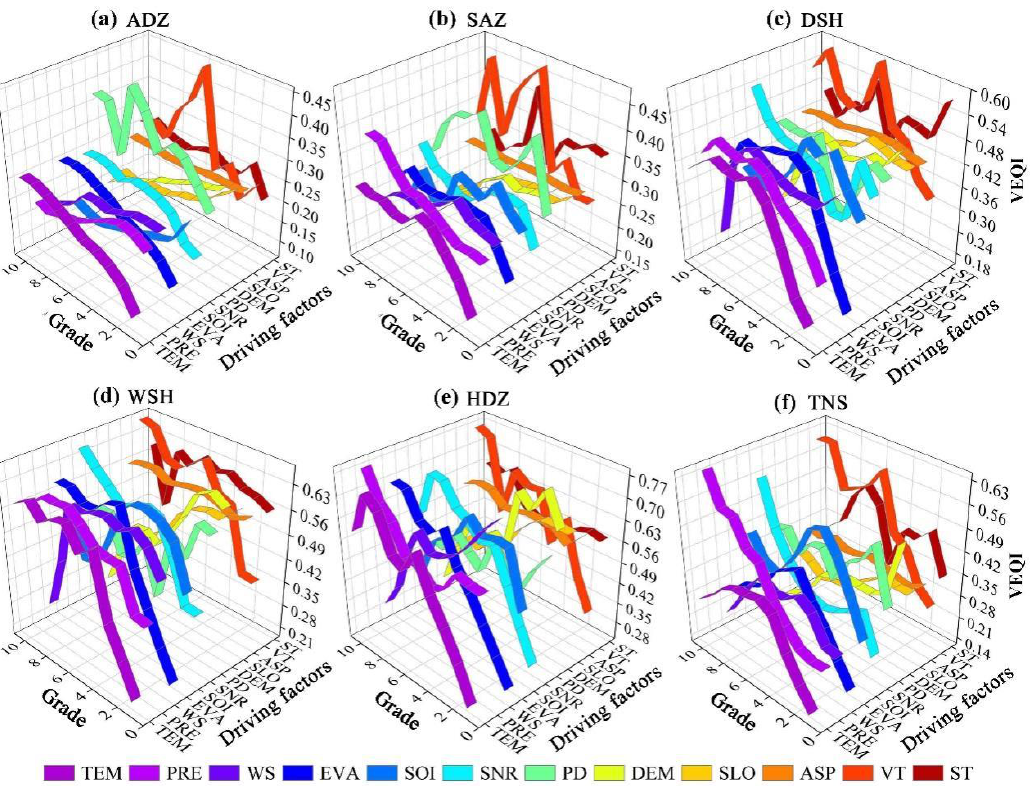
Figure 10. Statistical results of VEQI in the TNS ( f ) and each climate zone ( a – e ) at each level of influence.